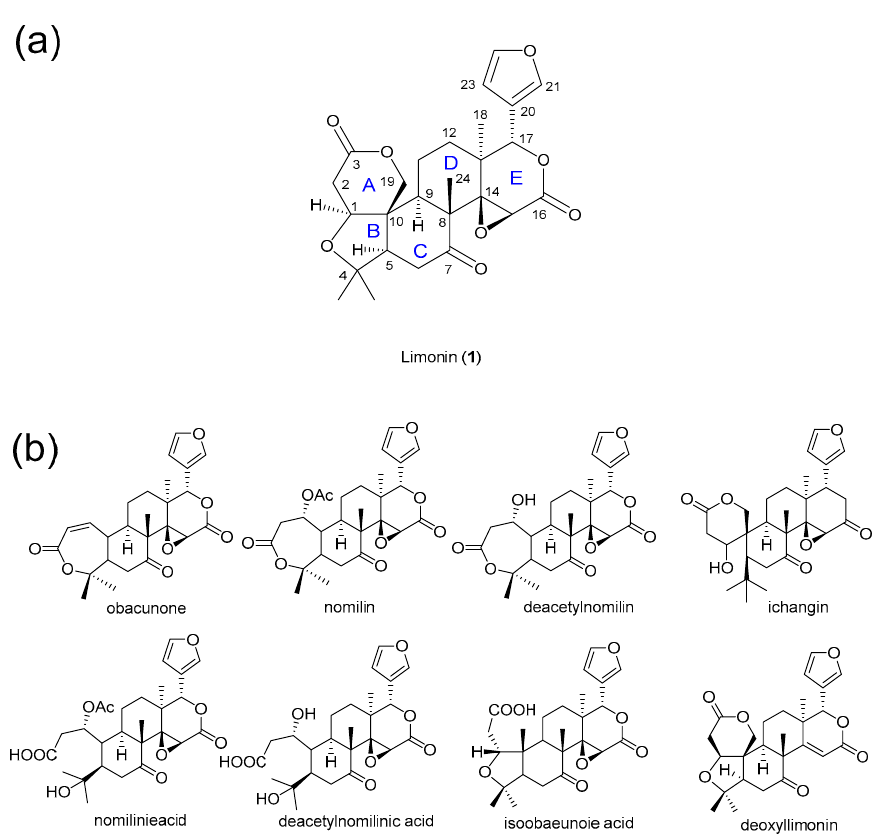
Figure 1. Structures of ( a ) limonin and ( b ) limonoids found in citrus fruits.